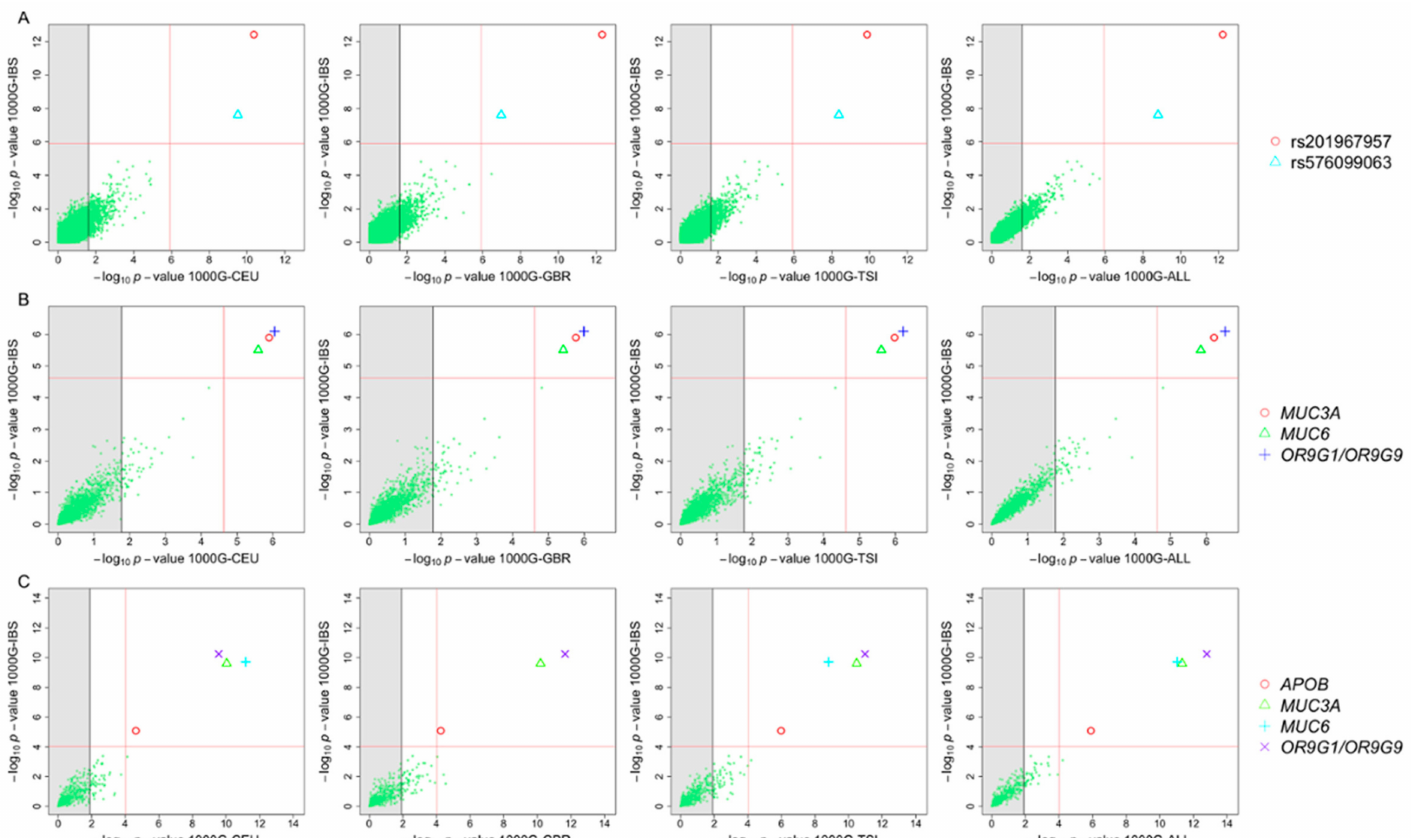
Figure 3. ( A ) p -values of association tests carried out between cases and different 1000G control groups computed on single nucleotide polymorphisms (SNPs). ( B ) p -values of gene burden association tests between patients and controls using common variants. ( C ) p -values of gene burden association tests between patients and controls using rare variants (minor allele frequency, MAF < 0.05 for the 1000G-IBS cohort). The grey shadow to the left of each individual graph indicates the threshold for the corresponding Bonferroni adjustments according to the number of candidate SNPs/genes. The red lines indicate the genomic Bonferroni threshold for the two control groups being compared in each graph. The legend on the right indicates the SNPs/genes surpassing the genomic Bonferroni’s